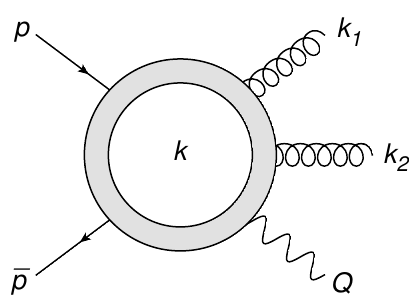
Figure 1 . Contribution to the Drell-Yan process at N 3 LO, consisting of two real gluon emissions dressing the one-loop amplitude. The latter involves a loop momentum k